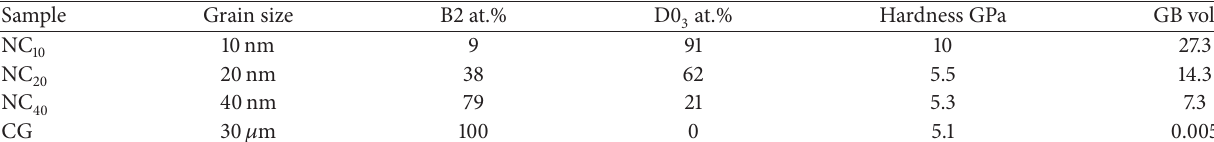
Si alloys. 88 12